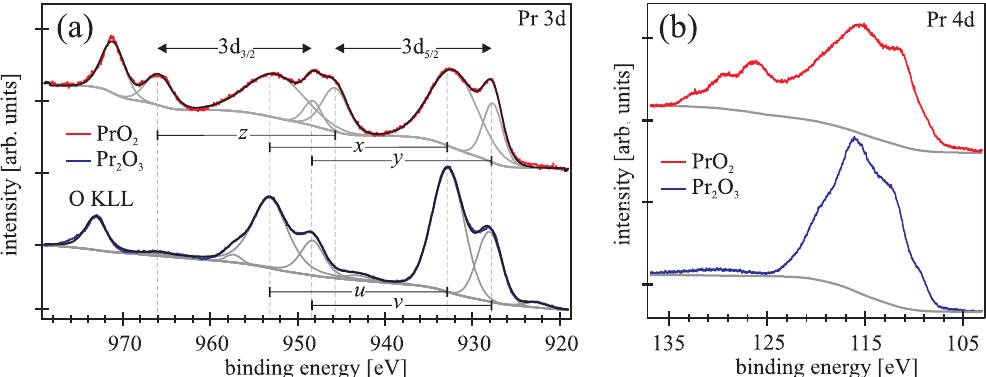
Figure 1. Pr 3d ( a ) and Pr 4d ( b ) photoemission spectra from praseodymia films before